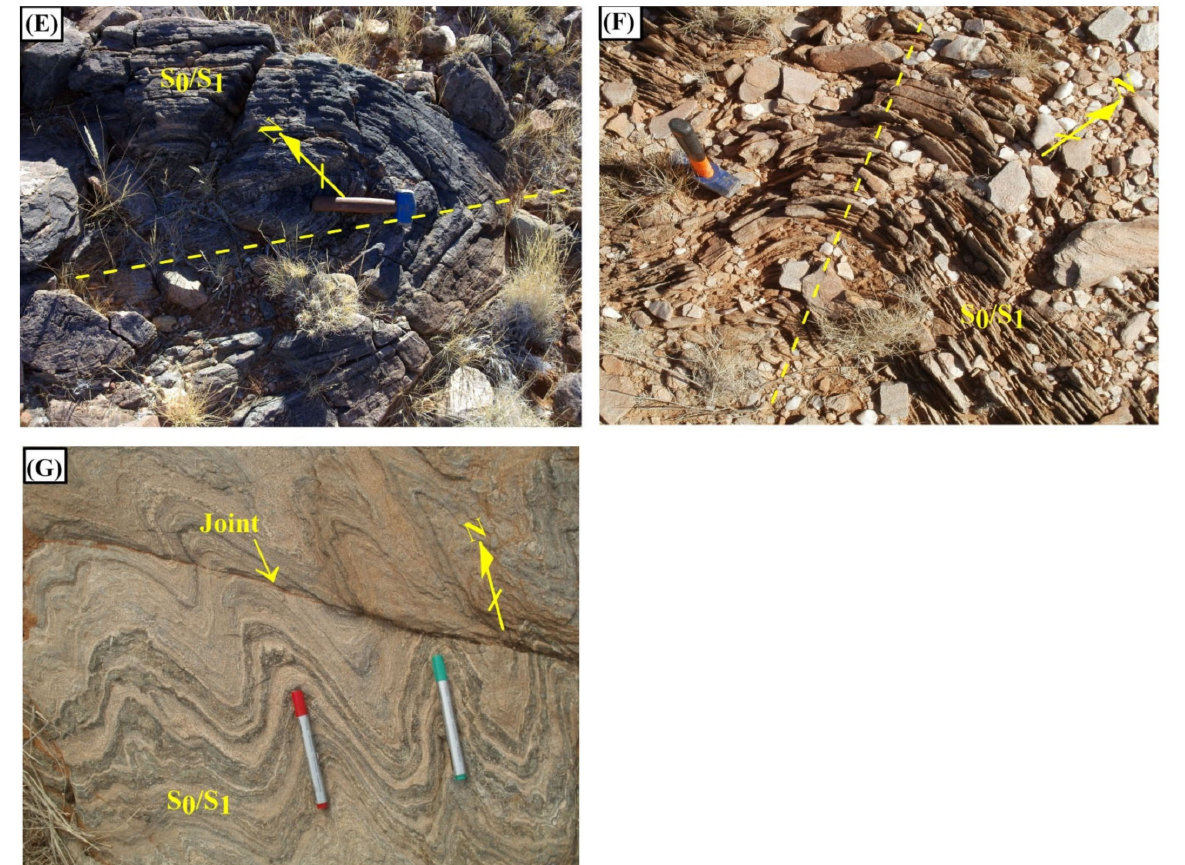
Figure 7. ( A ) Panoramic view of the closure displayed by the calc-silicate-rich quartzite in sub-area 1. The direction of view is towards the southeast. The white dotted line delineates the synformal structure in sub-area 1. ( B ) Detailed mapping of the closure outlining a synformal structure in the Neusberg. S 0 and S 1 foliations are co-planar, and, together with the fold axis, define a north-easterly plunging synformal structure in subarea 1. ( C ) Panoramic view of the closure illustrated by the calc-silicate-rich quartzite in subarea 2. The direction of view is towards the northeast. The white dotted line shows an antiformal structure in sub-area 2. ( D ) Detailed mapping of the closure showing an antiformal structure in the Neusberg. S 0 and S 1 foliations are co-planar, and together with the fold axis, define a north-easterly plunging antiformal structure in subarea 2. ( E ) Outcrop of feldspathic mica-rich quartzite within the closure in sub-area 1 showing a synformal structure. The yellow dashed line indicates an axial trace trending northwest–southeast. ( F ) Outcrop of feldspathic-mica-rich quartzite displaying an antiformal structure within the closure in sub-area 2. The yellow dashed line shows an axial trace trending towards the northwest–southeast. ( G ) Parasitic folds within an outcrop of calc-silicate-rich quartzite in sub-area 3. The axial trace of the parasitic folds trend north–south and are illustrated by parallel green and red pen